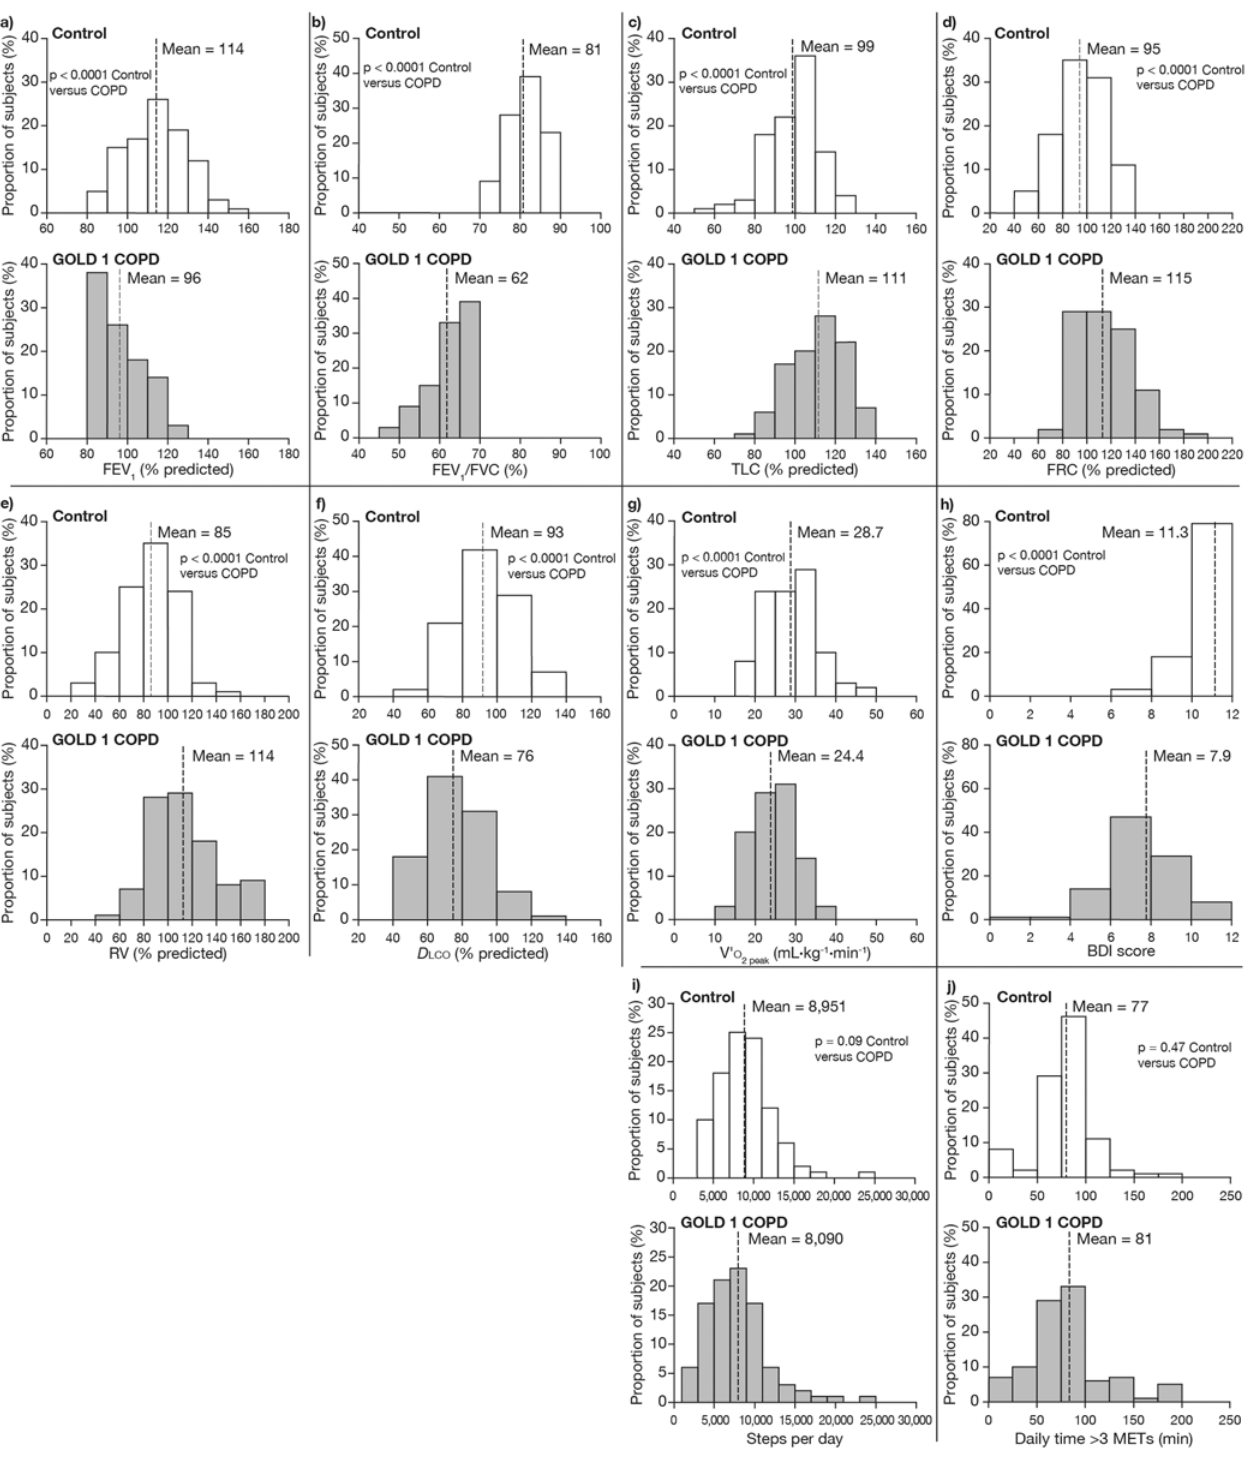
Fig 1. Frequency distributions for pulmonary function, peak V 0 o 2 , BDI score and physical activity. a) forced expiratory volume in 1 second (FEV 1 ); b) FEV 1 /forced vital capacity (FVC) ratio; c) total lung capacity (TLC); d) functional residual capacity (FRC); e) residual volume (RV); f) diffusion capacity ( D LCO ); g) peak oxygen uptake (V 0 O 2 peak); h) baseline dyspnea index (BDI) score; i) number of steps per day; j) and daily time spent in physical activity > 3 metabolic equivalents (METs). GOLD: Global Initiative for Chronic Obstructive Lung